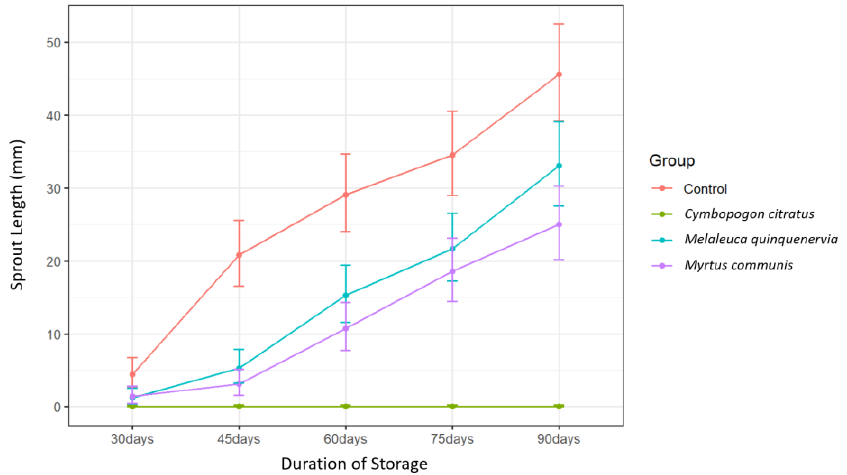
Figure 1. Sprout length (mm) over time of potatoes treated with distilled water (control), Cymbopogon citratus , Myrtus communis , and Melaleuca quinquenervia EOs. Error bars represent the 95% confidence level of the back-transformed means ( emmeans method ).